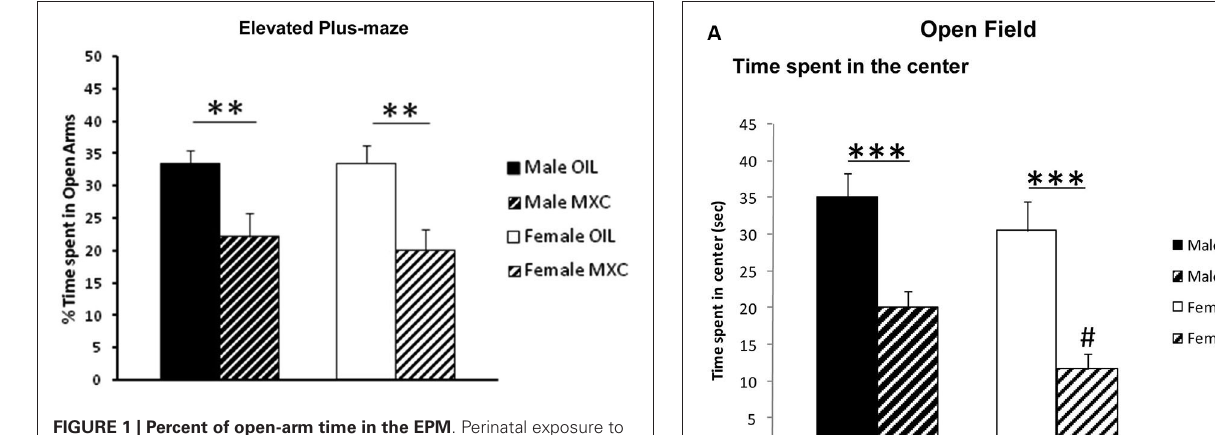
FIGURE 1 | Percent of open-arm time in the EPM . Perinatal exposure to MXC in both male and female mice revealed a significant decrease in the percentage of time spent in the open arms compared to control groups. Data are expressed as mean ± SEM. ** p < 0.01.